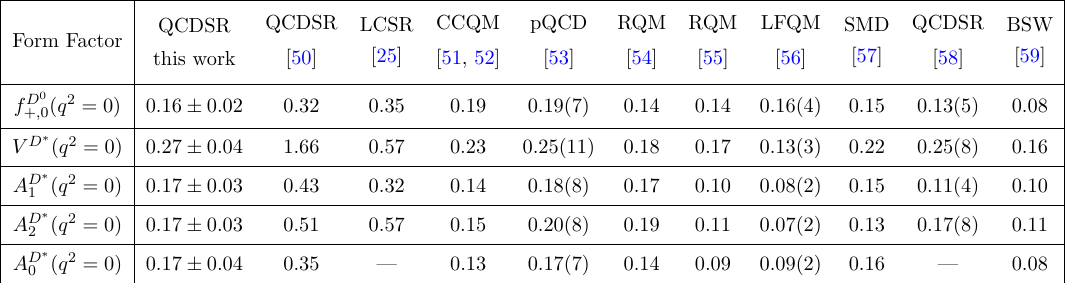
Table 3 . Form factor predictions at q 2 = 0 in various